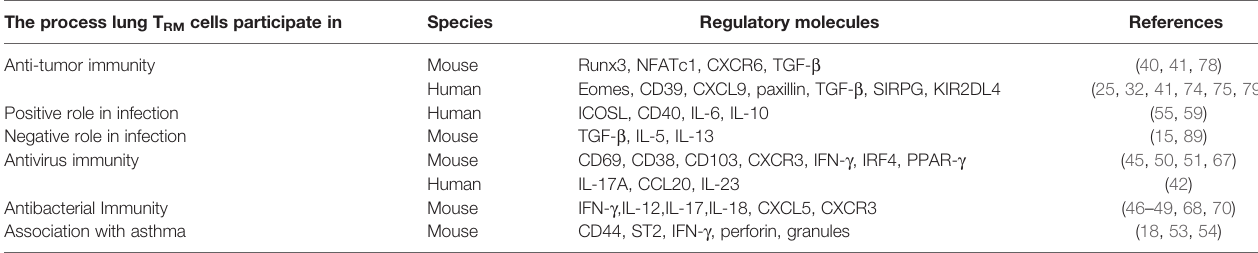
TABLE 4 | Molecules in mice or/and humans regulating lung T RM cells. The process lung T RM cells participate